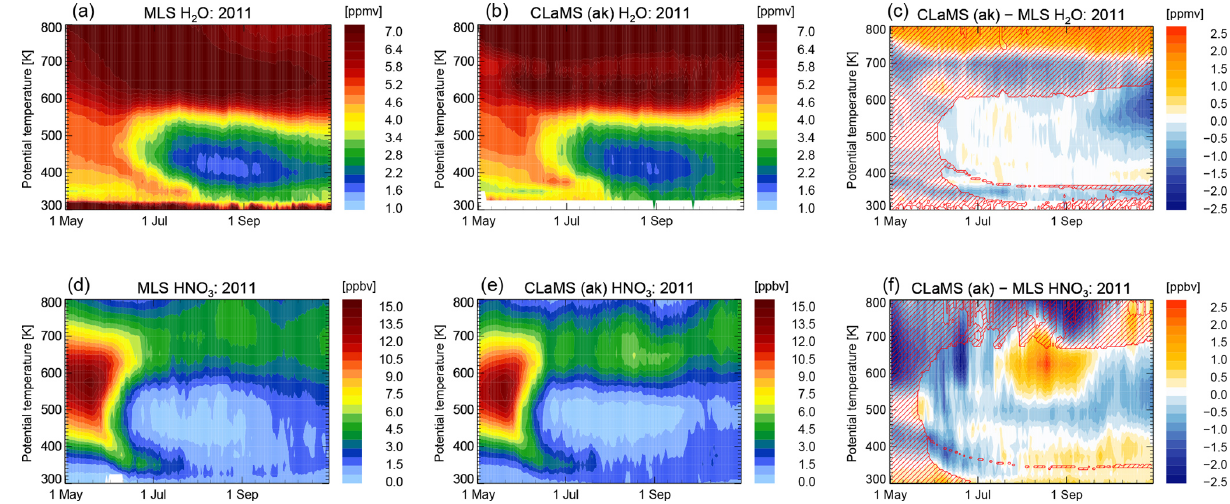
Figure 10. Same as Fig. 5 but for the 2011 SH winter from 1 May 2011 until 31 October 2011 and for equivalent latitudes > 70 ◦